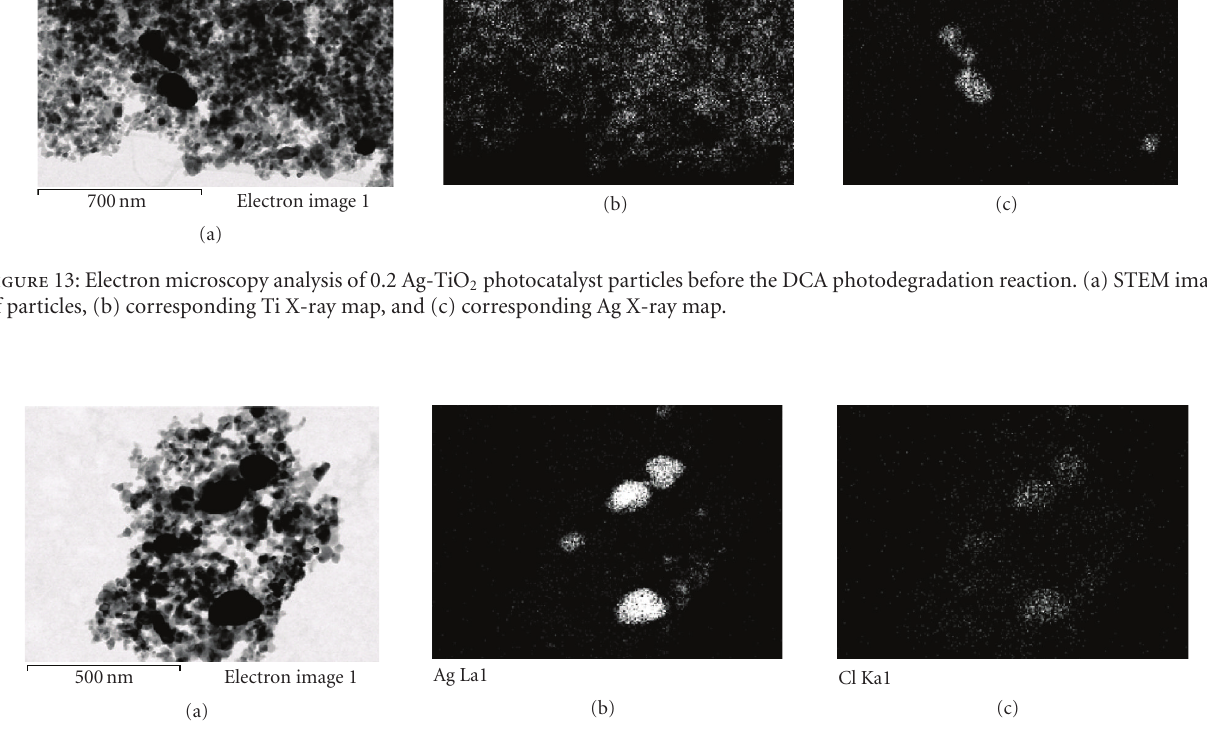
Figure 14: Electron microscopy analysis of 0.2 Ag-TiO 2 photocatalyst particles after the DCA photodegradation reaction. (a) STEM image of particles, (b) corresponding Ag X-ray map, and (c) corresponding Cl X-ray